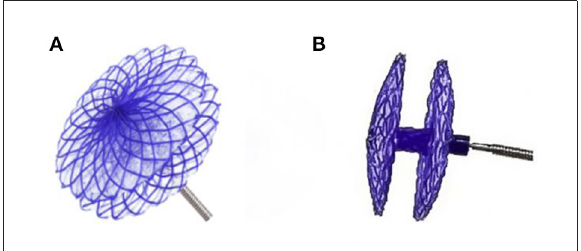
FIGURE1 Biodegradable occluder. (A) The positive view of the occluder; (B) side view of the occluder.